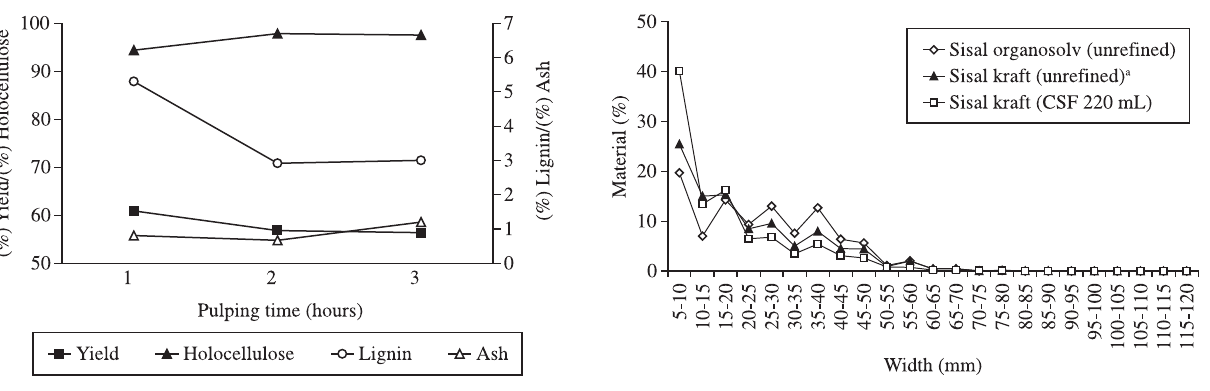
Figure 4. Width distribution of the fibrous material. ( a ) Tonoli et al. 29